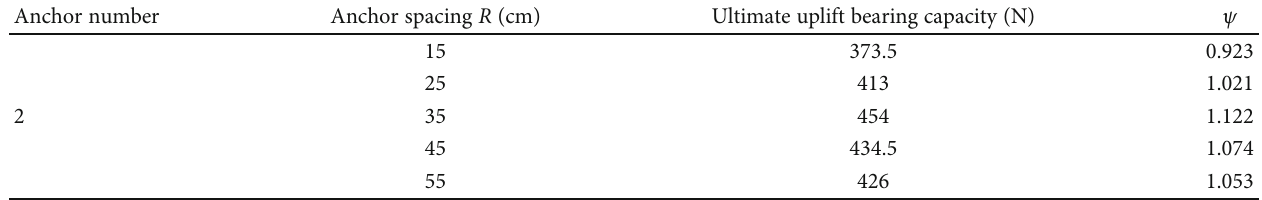
Figure 8: The total ultimate bearing capacity ( G Table 4: The ECO of multiple in fl atable anchors for two anchors with di ff erent spacing.